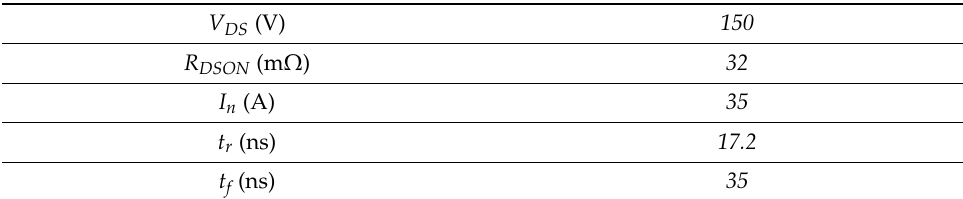
Table 11. TLI-MOSFET (IRFB5615PBF).